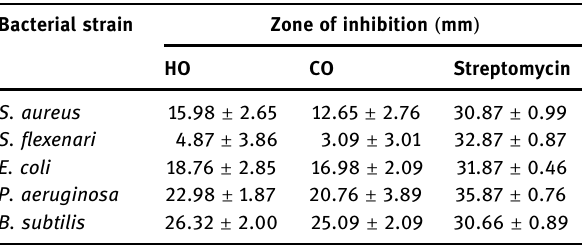
Table 4: Antibacterial e ff ects of oil extracts from HO and CO frac - tions of F. benghalensis Bacterial strain